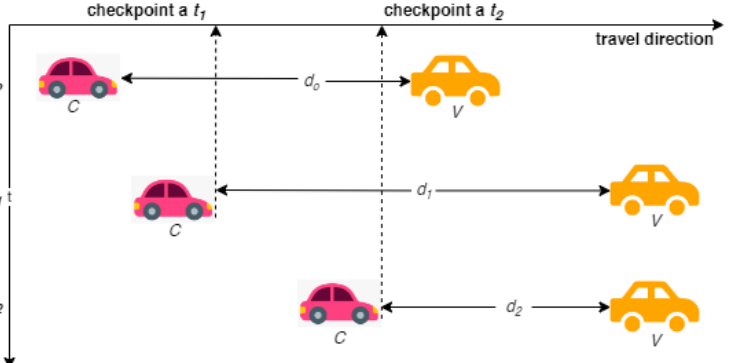
Figure 3. In order to meet the deadlines t 1 and t 2 set by the verifier, candidates are required to visit randomly generated checkpoints d 1 and d 2.